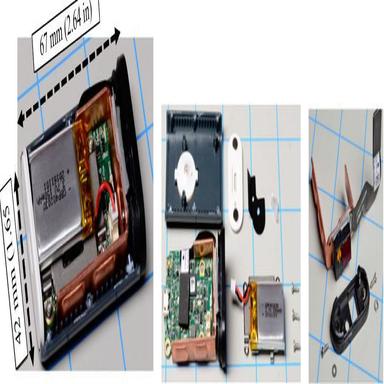
Different parts of the sensor.